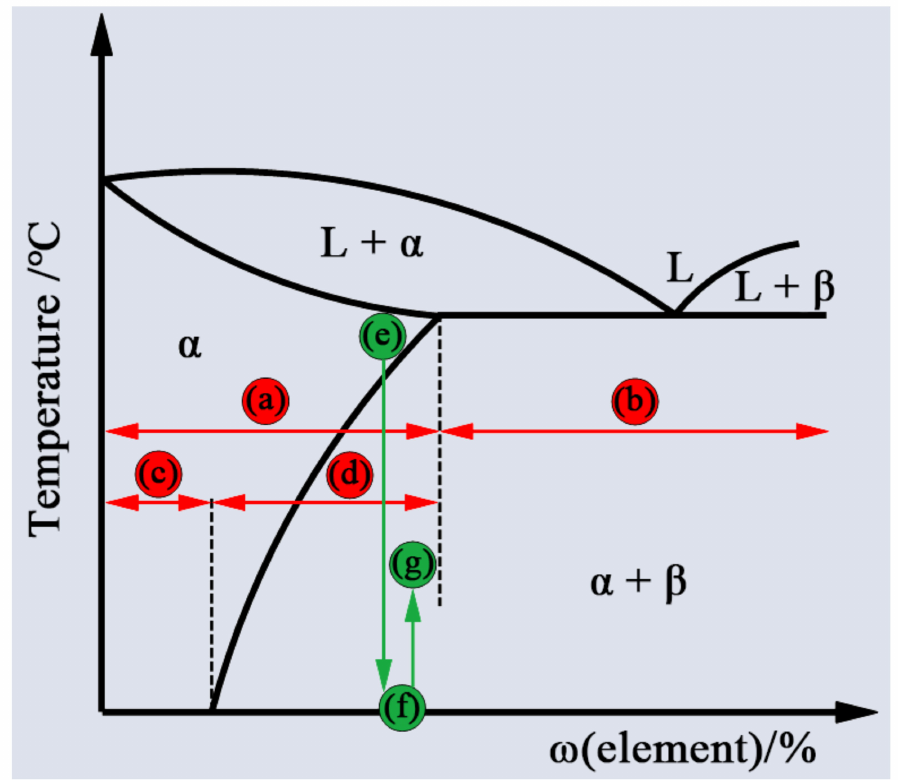
Figure 1. Schematic diagram of the classification of aluminum alloys (red line) and solution, quench- ing and aging heat treatment process (green line). ( a ) Wrought aluminum alloy; ( b ) cast aluminum alloy; ( c ) non-heat-treatable aluminum alloys; ( d ) heat-treatable aluminum alloys; ( e ) solution heat treatment; ( f ) quenching treatment; ( g ) aging